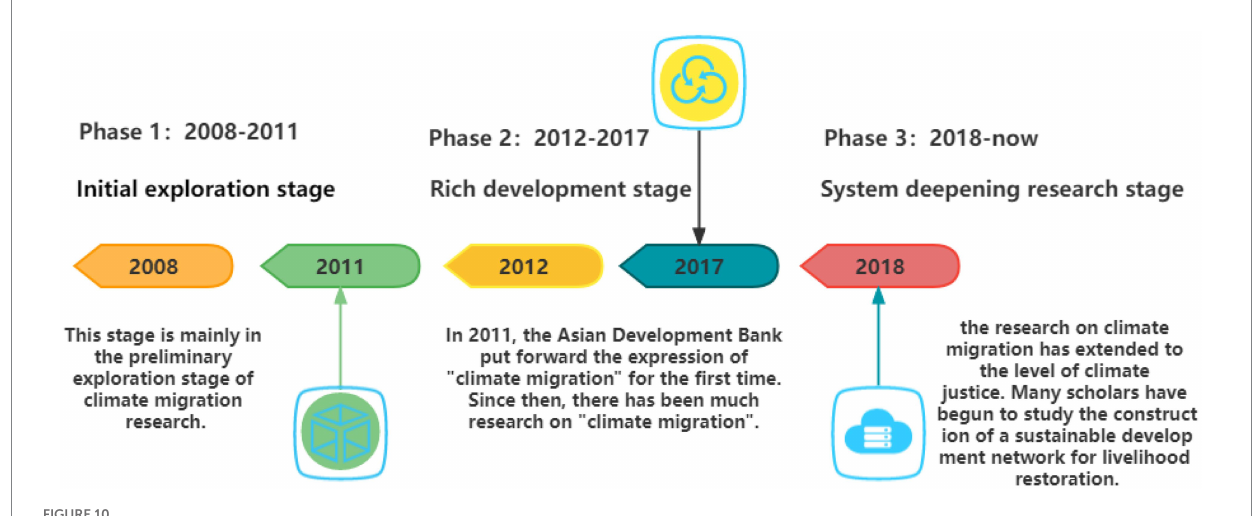
FIGURE 10 Division of research